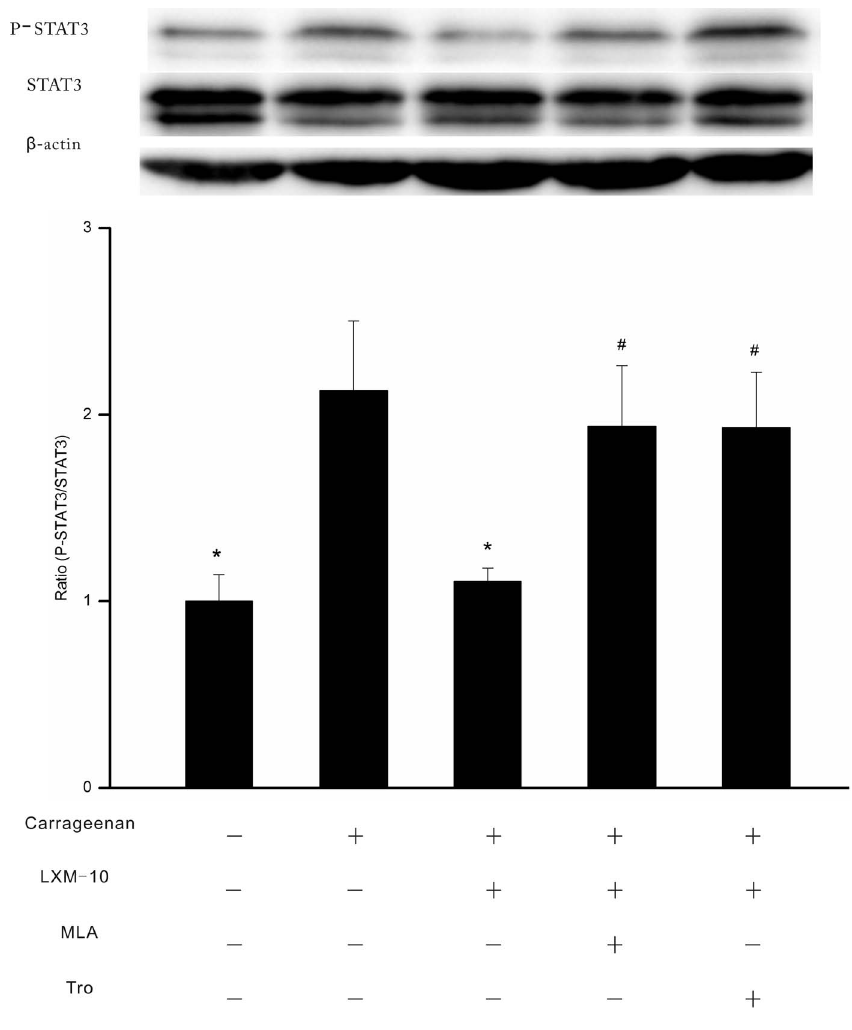
Figure 5. Effect of LXM-10 on expression of P-STAT3 was attenuated by methyllycaconitine citrate and tropicamide. The rats were treated with methyllycaconitine citrate (MLA, 3 mg/kg, i.p.), tropicamide (Tro, 3 mg/kg, i.p.) or vehicle before administration of LXM-10 (6 mg/kg, i.g.) or vehicle. The expression of STAT3 and P-STAT3 in hind paws was detected at 3 h after carrageenan challenge. All data are mean 6 SEM of 6 rats per group. * P , 0.05 vs Vehicle, # P , 0.05 vs